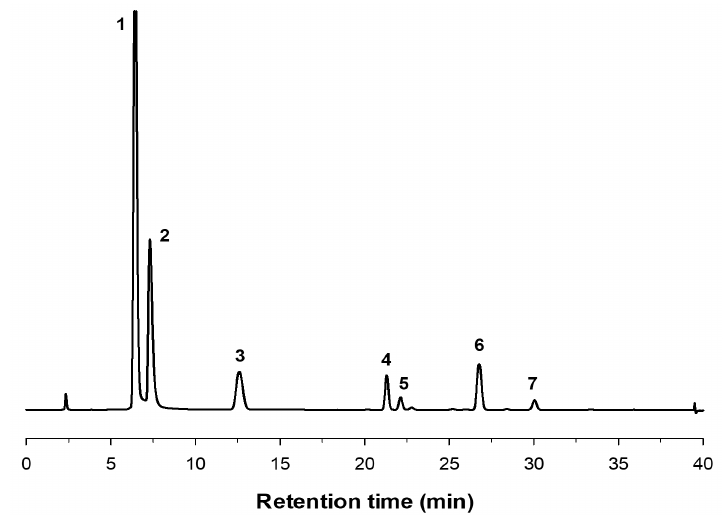
Figure 3. HPAEC-PAD chromatogram of the reaction of 600 g/L sucrose at 50 °C with pXd-INV entrapped in PVA. (1) Glucose; (2) Fructose; (3) Sucrose; (4) 1-Kestose; (5) Blastose; (6) Neokestose; (7) Neonystose.